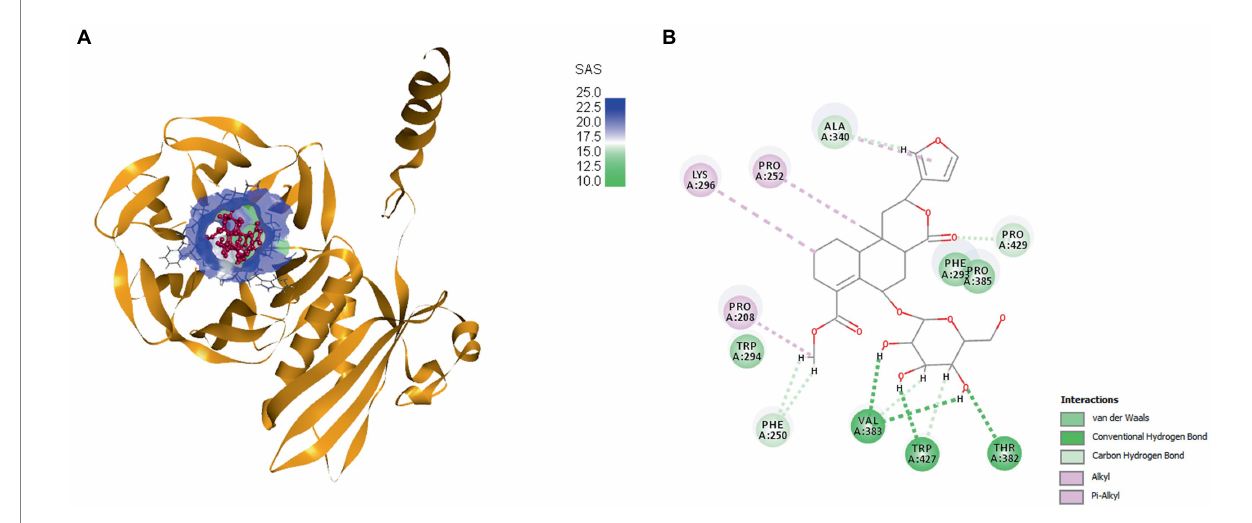
FIGURE 14 (A) Docked pose of Cordifoliside C with TolB, (B) Various bonded and non-bonded interactions of Cordifoliside C with TolB.